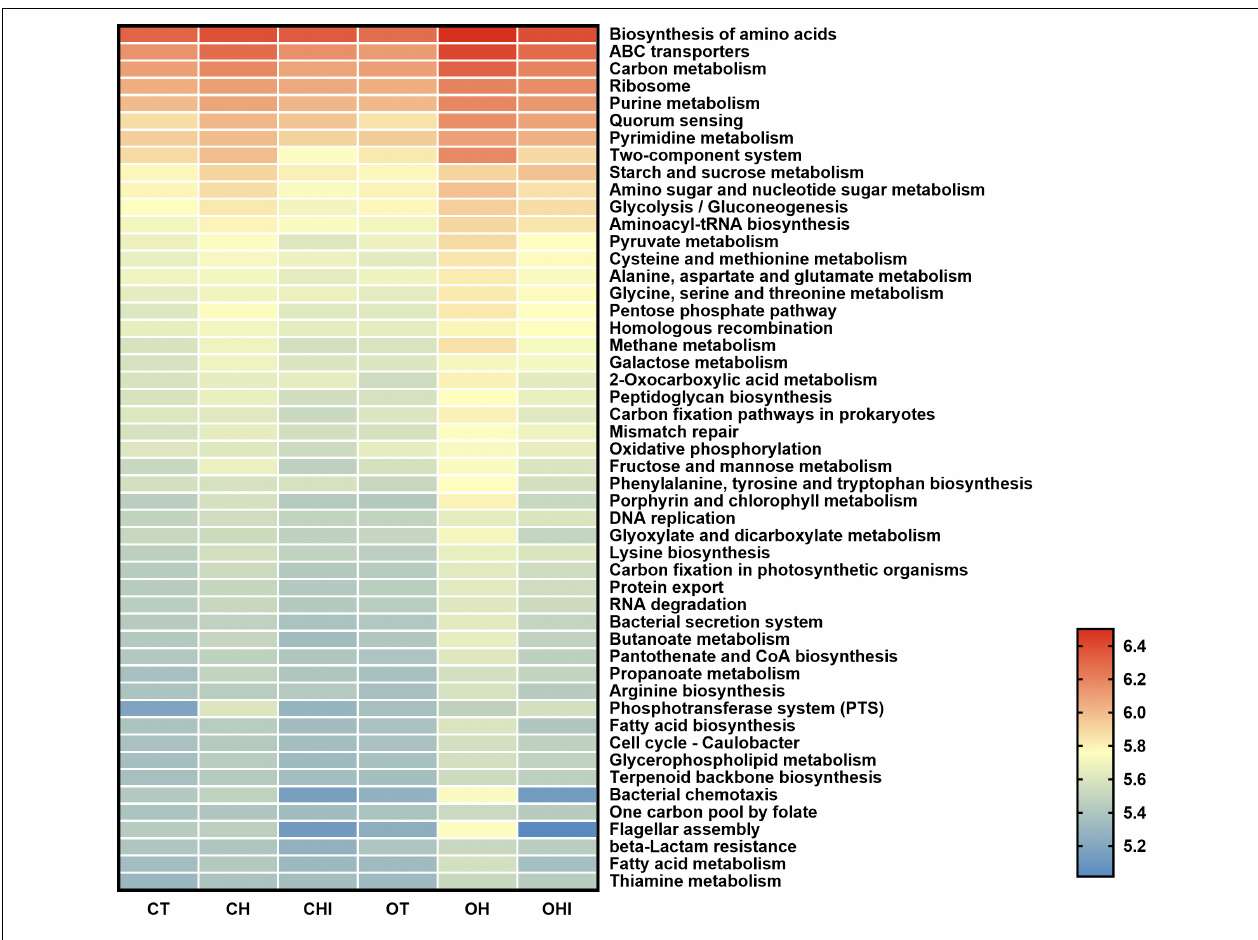
FIGURE 8 | Top 50 pathway into level 3 KEGG as predicted by